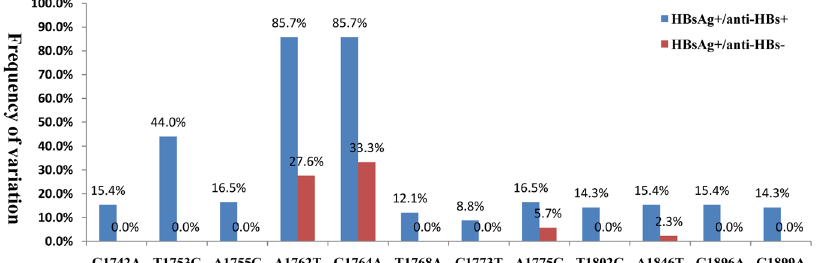
Figure 6. Frequency of nucleotide point mutations in the core promoter and precore regions (1742–1900 bp), p < 0.05.